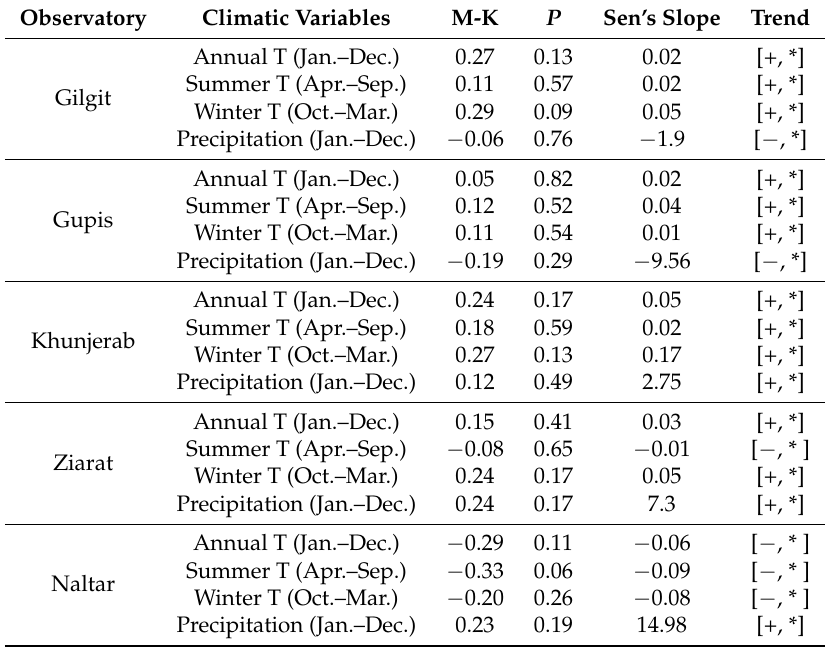
Table 2. Mann–Kendall statistics for the five observatories (1995–2013). M-K, and P are the Kendall’s tau, and the two-side p-value, respectively. (+ and − indicates positive trend and negative trend, + , * indicates significant and non-significant respectively at confidence level α = 0.05). T indicates the